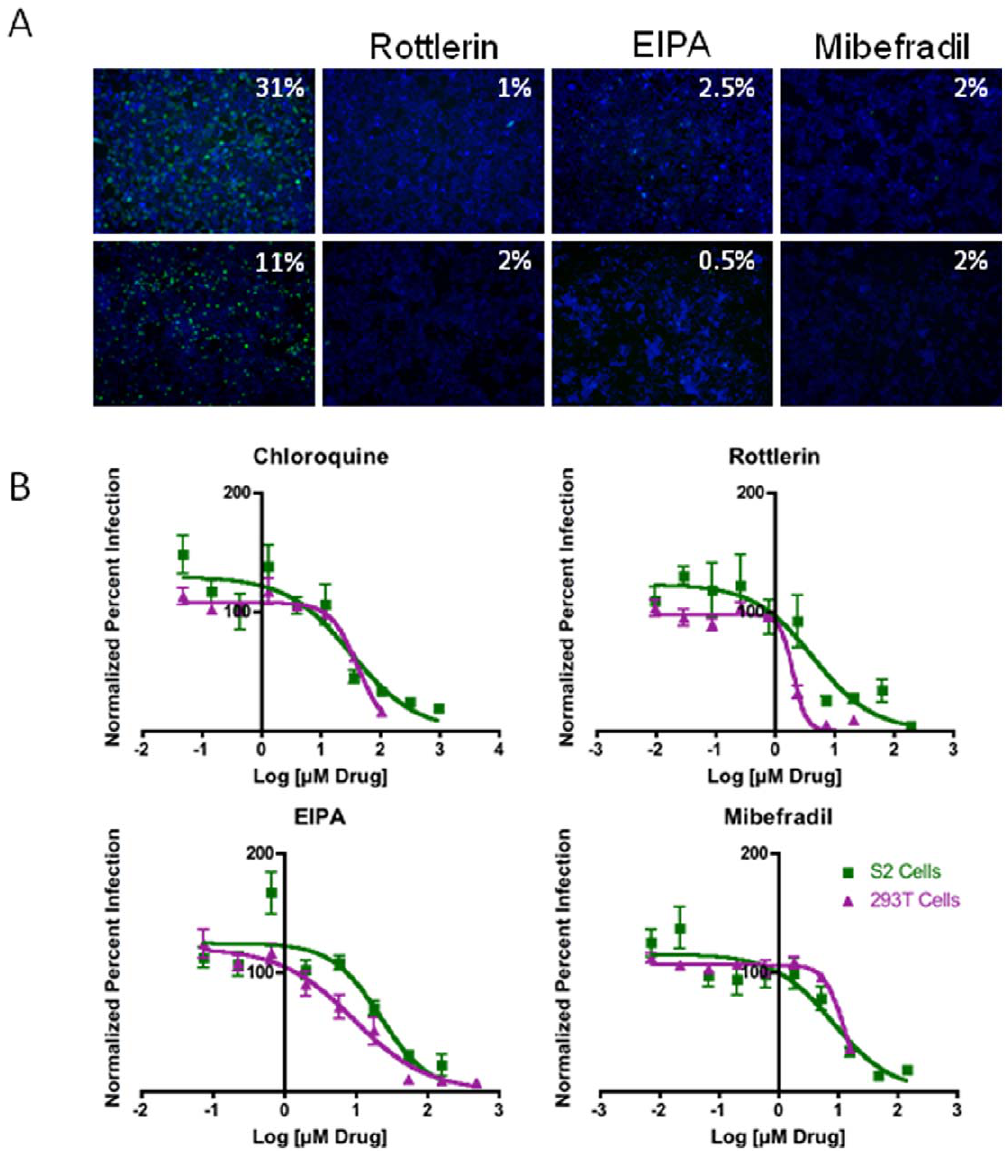
Figure 3. Validation of RVFV candidate inhibitors. A . 293T cells were pre-treated with 7 mM Rottlerin, 160 mM EIPA, 16 mM Mibefradil, or vehicle, and infected with RVFV MP12 (MOI=0.3) for 16 hours and monitored by immunofluorescence with anti-RVFV N (green) and the nuclear dye DAPI (blue). Infected cells were visualized by immunofluorescence and the percent infection quantified as above. B . Drosophila S2 cells were pre- treated with 21 mM Rottlerin, 53 mM EIPA, 48 mM Mibefradil, or vehicle, and infected with RVFV MP12 (MOI=0.05) for 48 hours and monitored by immunofluorescence with anti-RVFV N (green) and the nuclear dye DAPI (blue). Infected cells were visualized by immunofluorescence and the percent infection quantified as above. C . IC 50 concentrations for the indicated drugs were determined for mammalian 293T cells and Drosophila S2 cells.